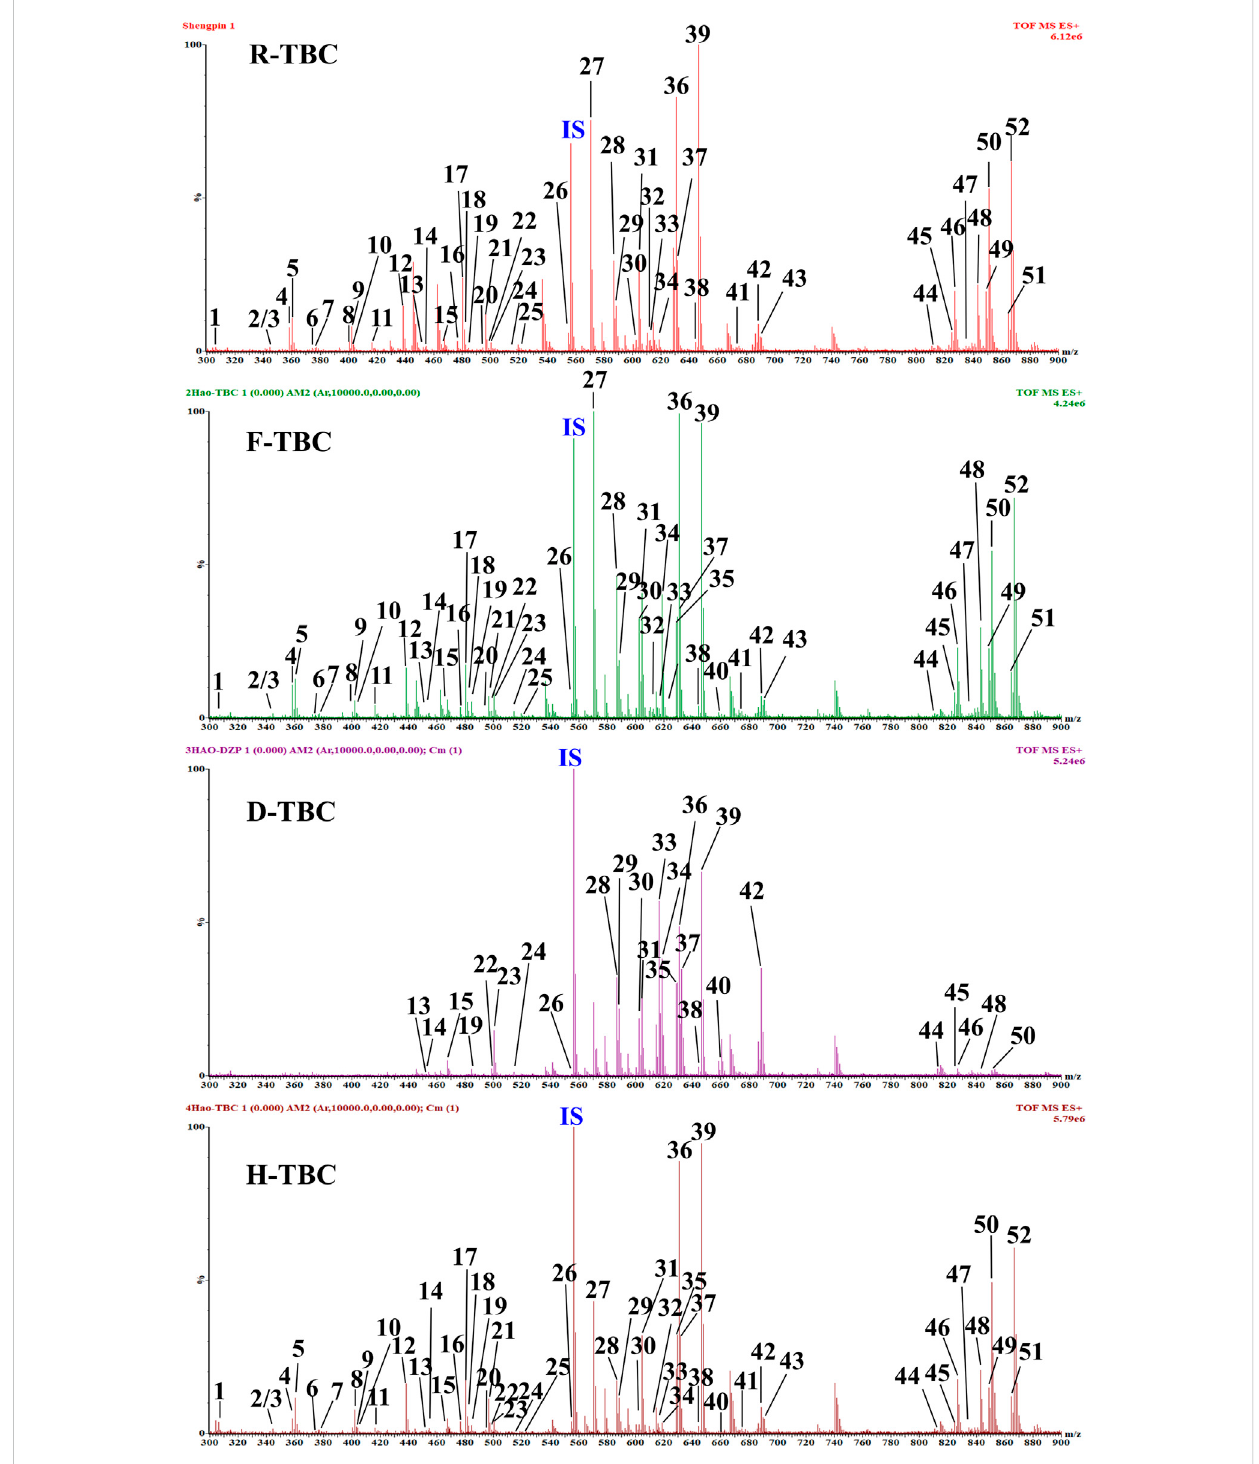
FIGURE 5 Signal of DESI-MSI acquired for mass range m/z 300 – 900 from HPTLC plate regions of the D-TBC, R-TBC, F-TBC and H-TBC in the positive ion mode. Putatively ident fi ed alkaloids are labeled with m/z and compound number. See Table 4 for more details on the compound identi fi